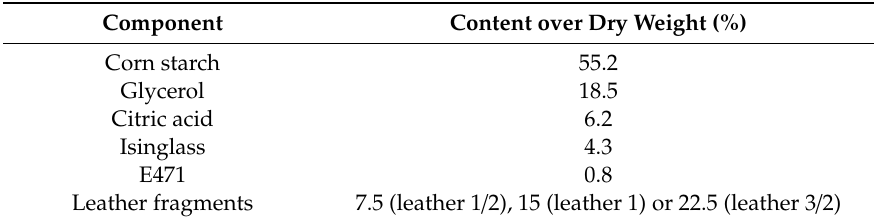
Figure 1. Experimental process leading to the development of the film.